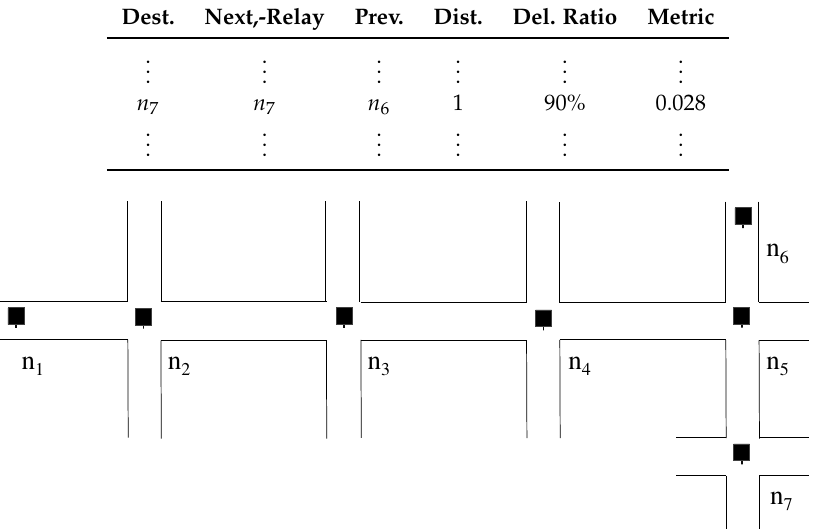
Figure 3. Example Scenario of Packet Forwarding in RDV (Reliable Distance-Vector routing): A packet is to be forwarded from n 2 to n 7 with the routing tables of n 2 and n 5 shown in Tables 2 and 3,